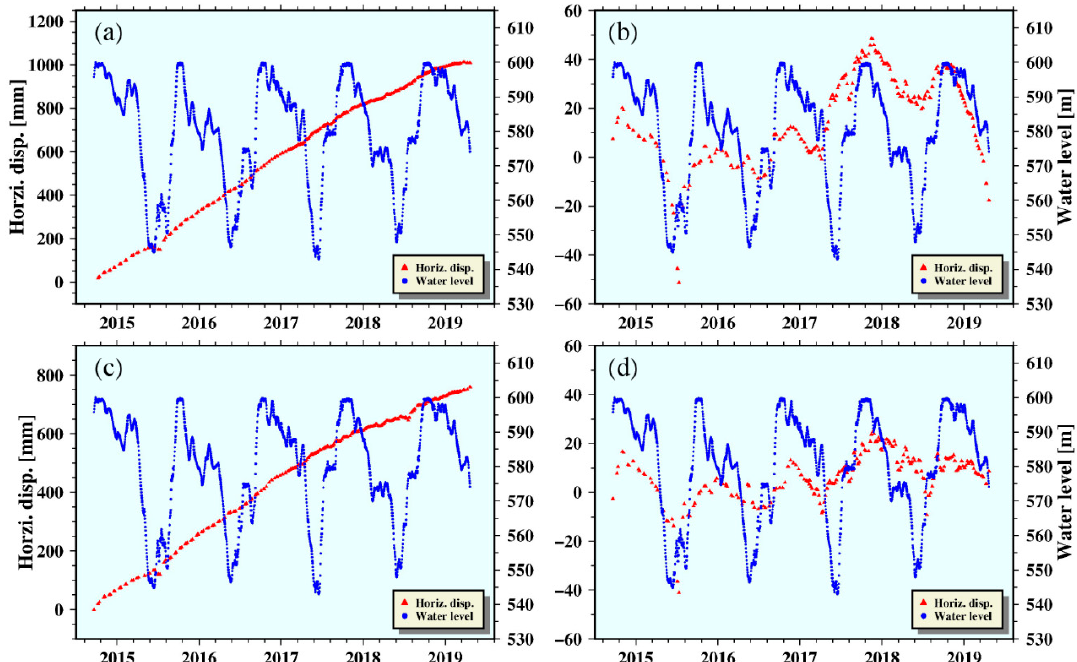
Figure 15. Relationship between horizontal displacement and impoundment. ( a ) is the relationship between the deformation sequence and water level in the horizontal direction of point P1 in Figure 10; ( b ) is the deformation sequence in ( a ) that removes the linear trend; ( c ) is the relationship between the deformation sequence and water level in the horizontal direction of point P2 in Figure 10; ( d ) is the deformation sequence in ( c ) that removes the linear trend.